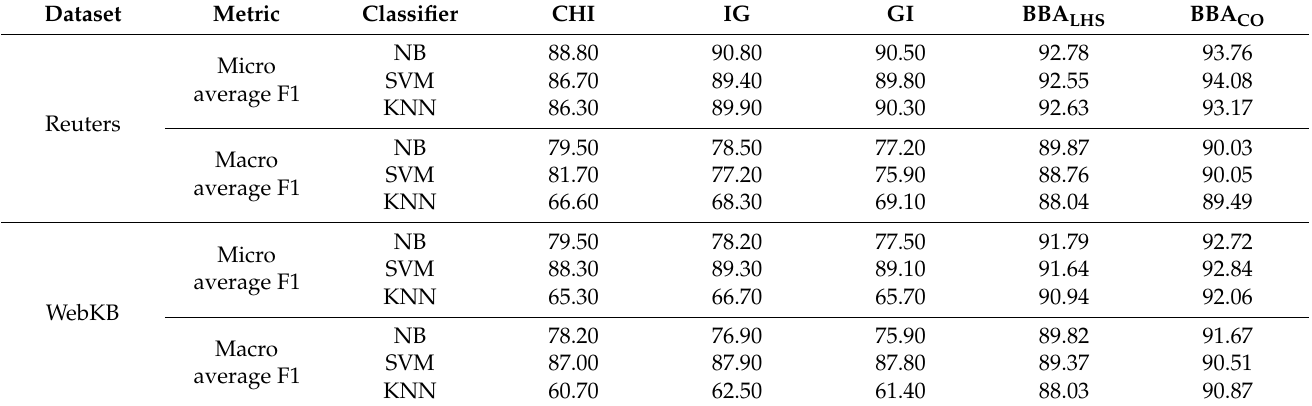
Table 10. Classification results using the feature sets generated by BBA LHS and BBA CO .